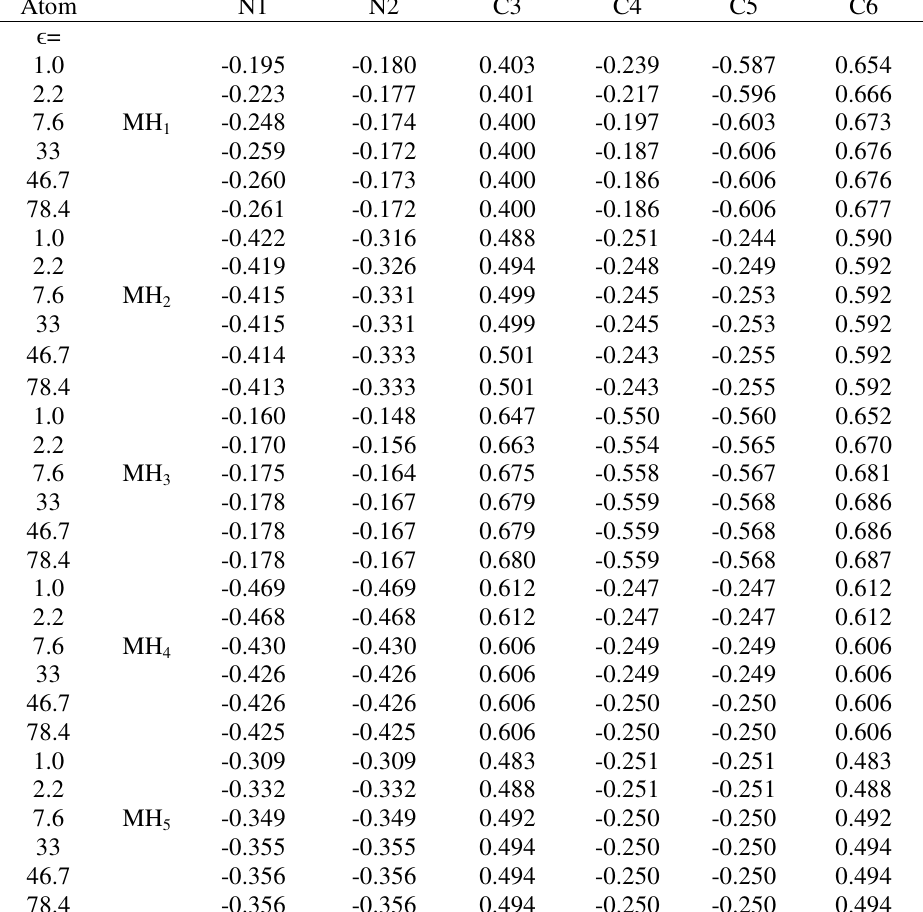
Table 4. Calculated NBO charges on ring atoms of maleic